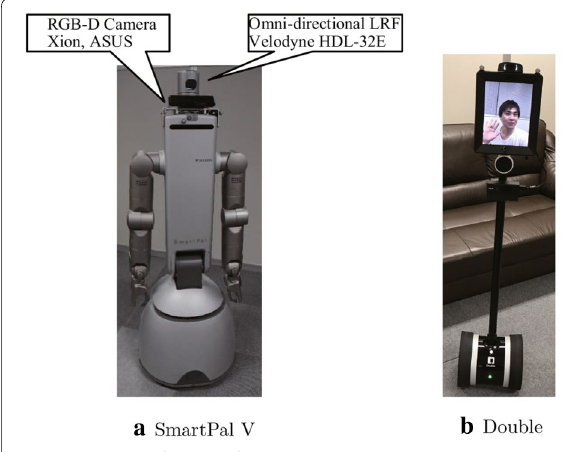
Fig. 12 Service robots used in Big Sensor